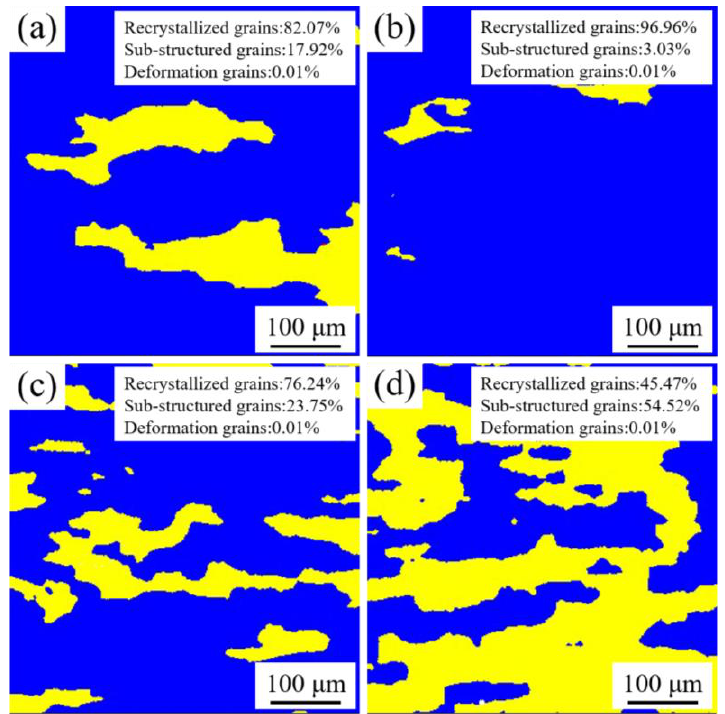
Figure 9. Recrystallized maps of the alloys after T6 treatment ( a ) AL1; ( b ) AL2; ( c ) AL3; ( d ) AL4.